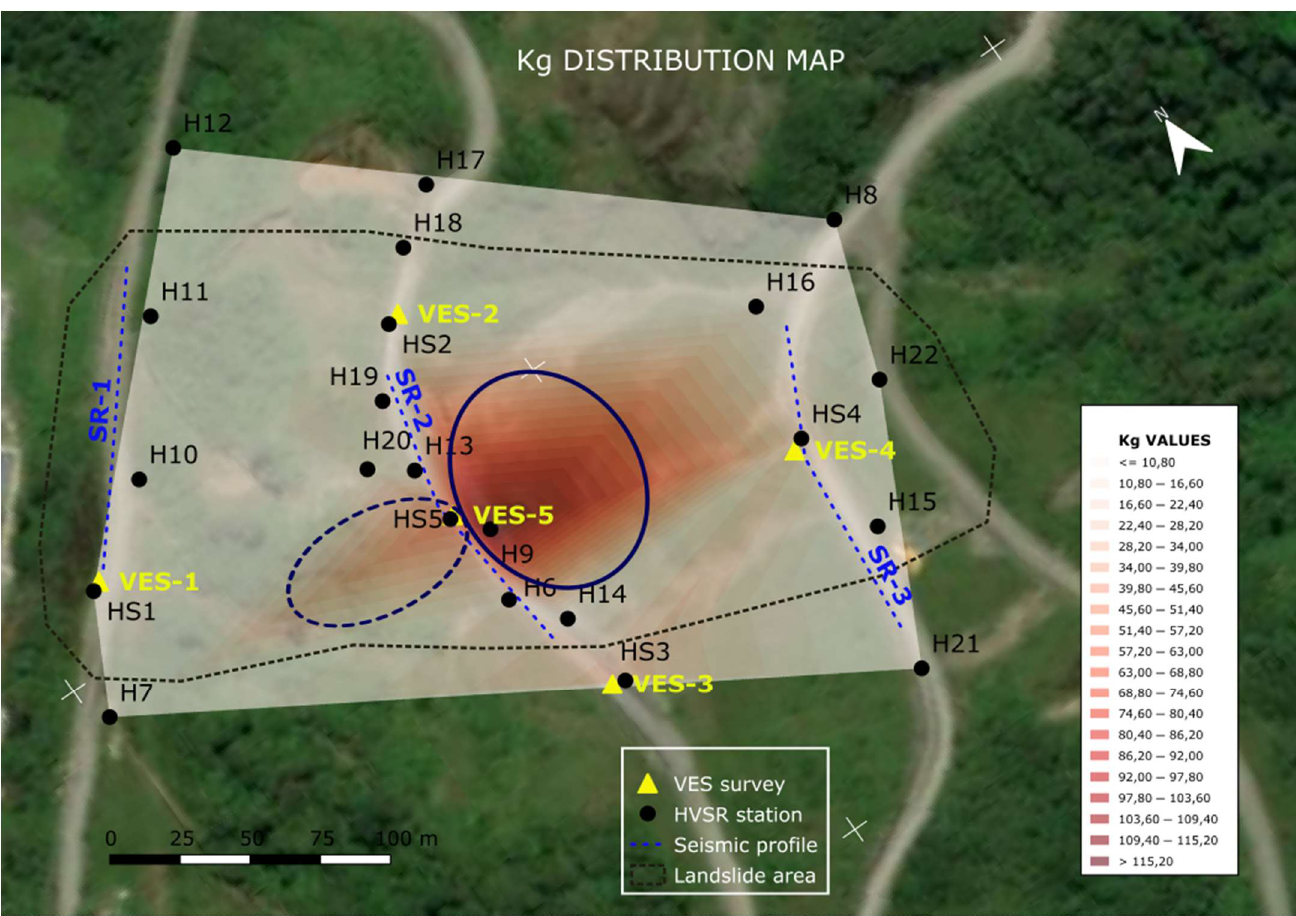
Figure 13. A distribution map of the K g values was represented in the investigation area. The maximums values coincide with the area presenting the most significant instability now (marked with dark blue ovals). White crosses refer to the coordinate points (Modified from [22]).